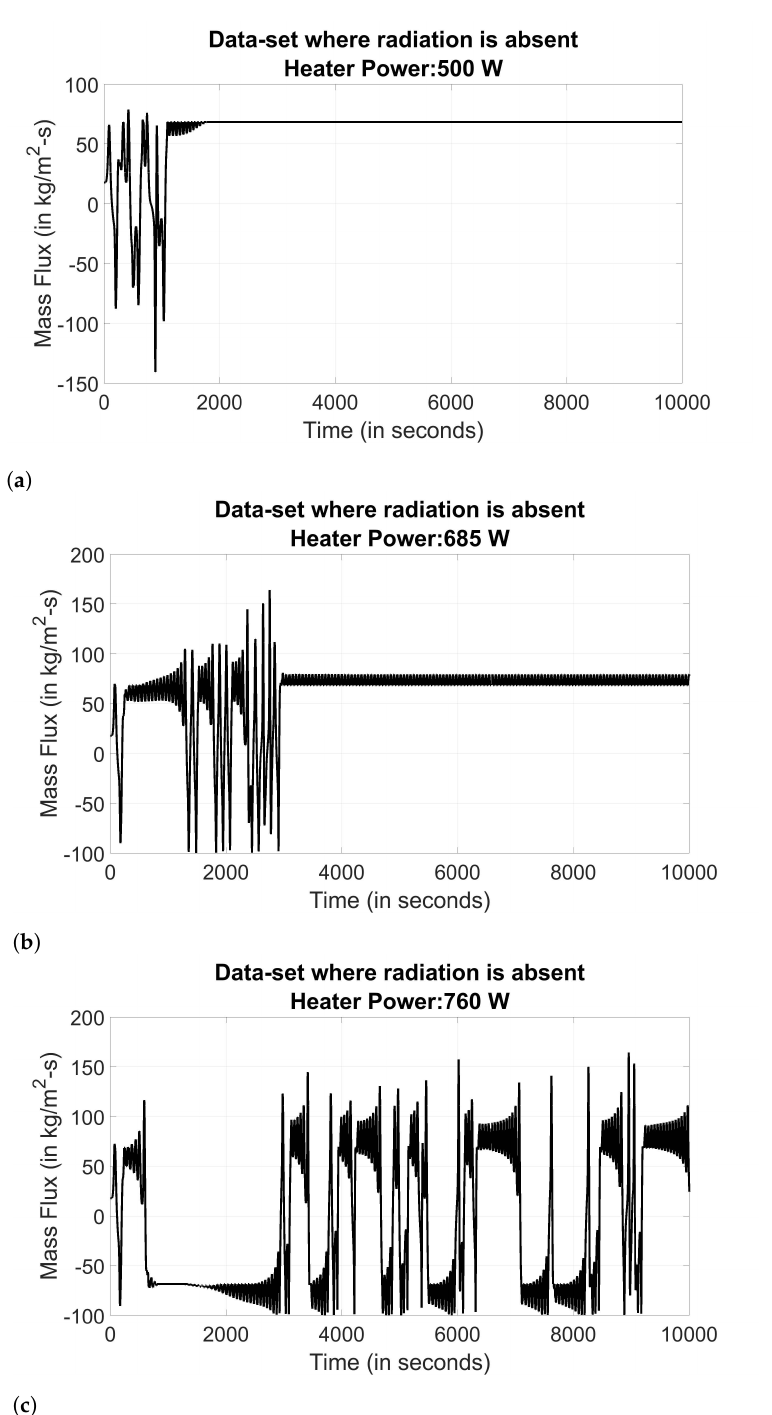
Figure 2. Sample mass-flux variation time series in absence of radiation heat loss for ( a ) Steady-state, ( b ) Oscillatory, and ( c ) Flow-reversal